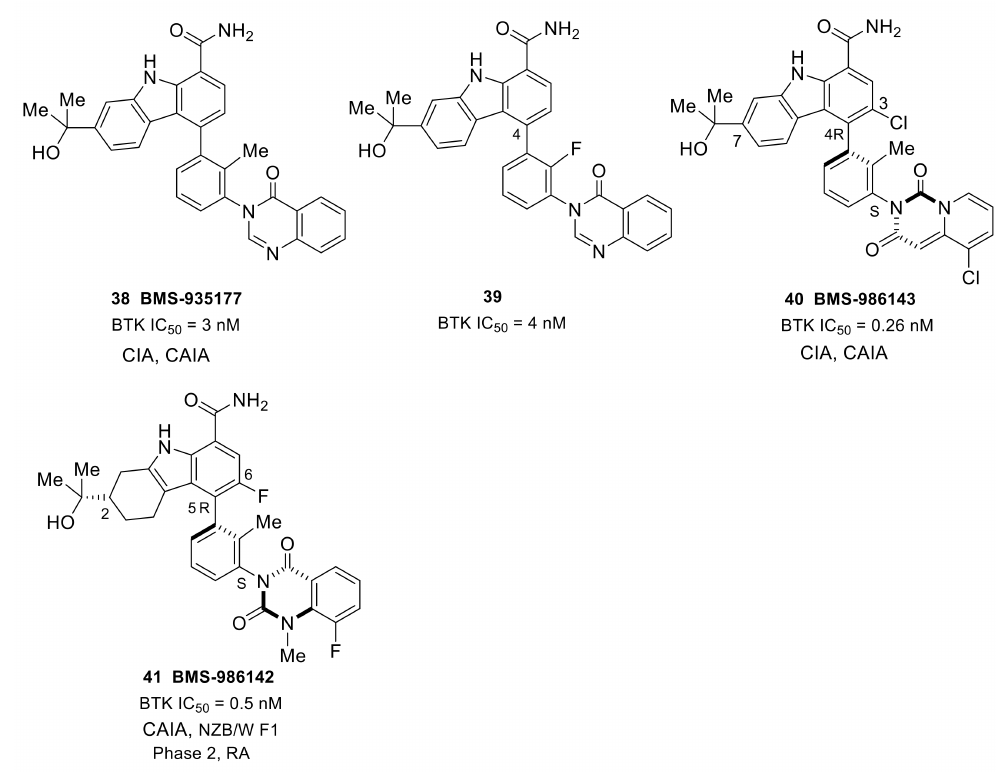
Figure 11. The representative structures of non-covalent reversible BTK inhibitors with fused tricyclic heterocycle scaffolds and their progress in the treatment of autoimmune and inflammatory